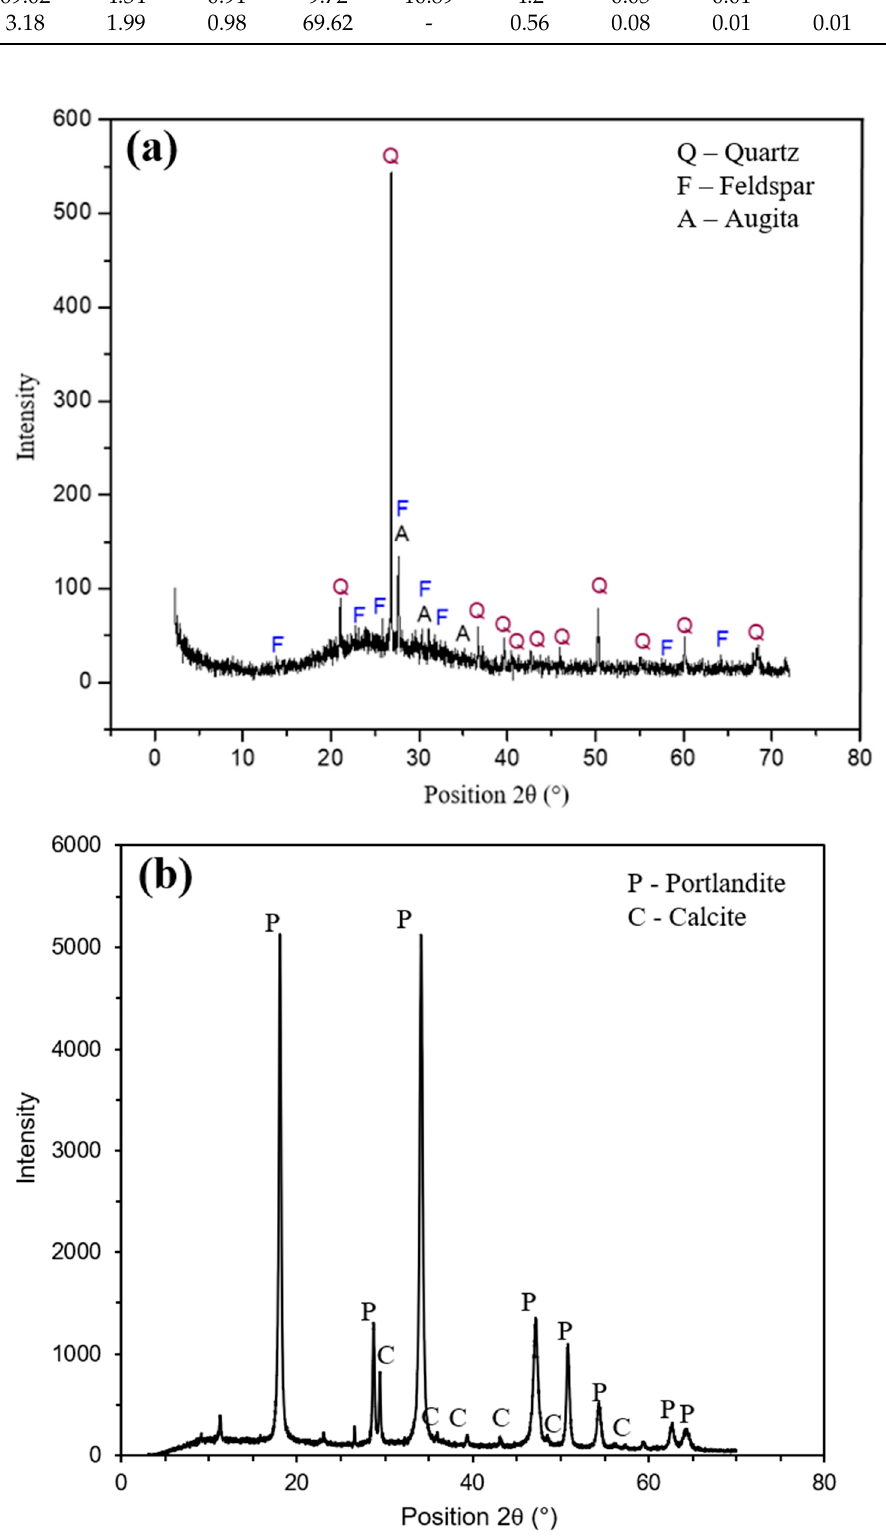
Figure 2. X-ray diffractometry ( a ) ground waste glass; ( b ) carbide lime waste.